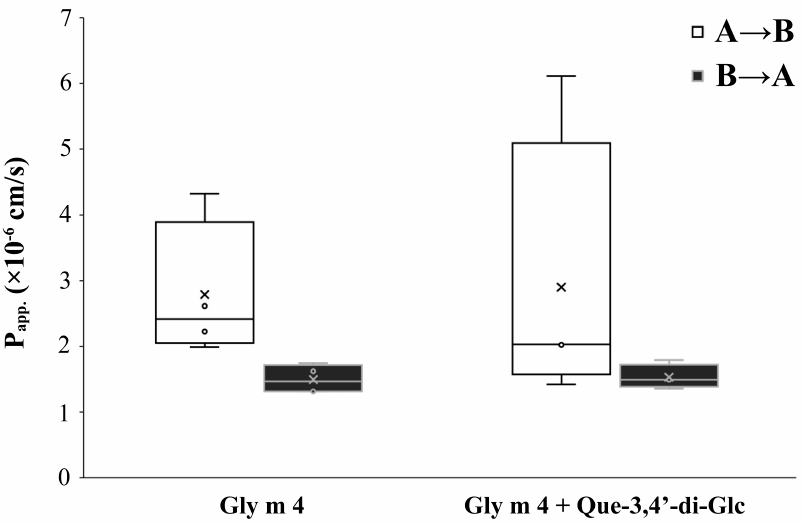
Figure 2. Bidirectional “apical-to-basolateral” (A → B) and “basolateral-to-apical” (B → A) transport of Gly m 4 across the Caco-2 epithelial barrier.